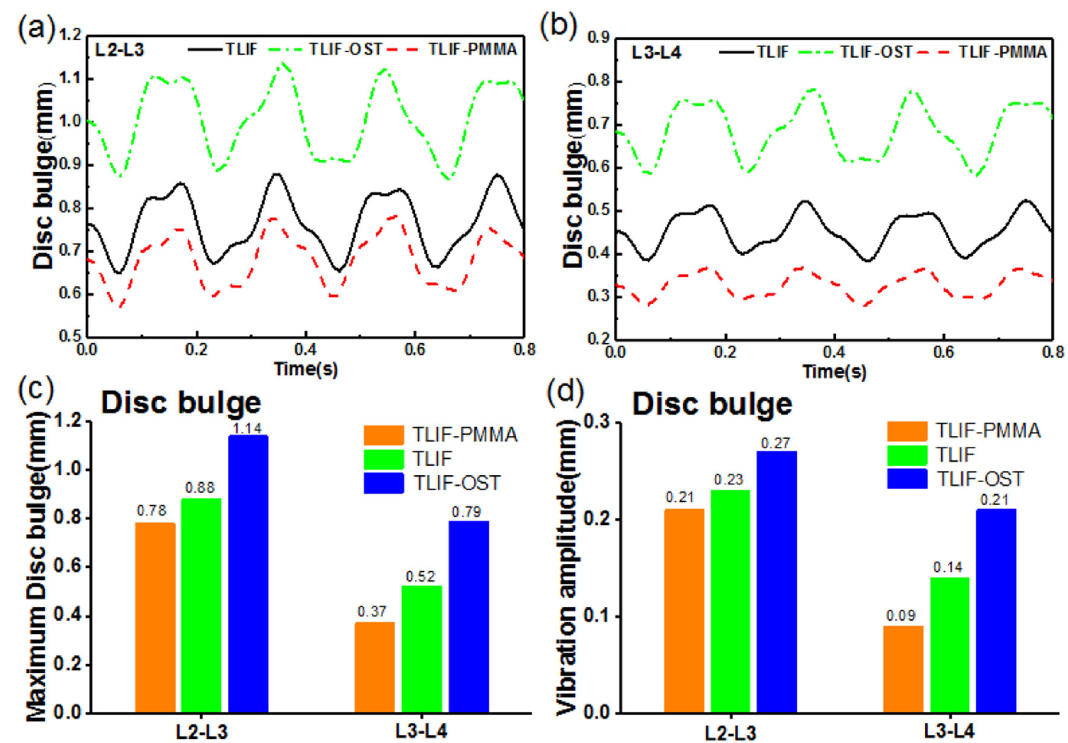
Fig. 3 The dynamic response at the adjacent segments for fusion models. a L2-L3 disc bulge b L3-L4 disc bulge c the maximum values of L2-L3 and L3-L4 disc bulge d vibration amplitudes of L2-L3 and L3-L4 disc